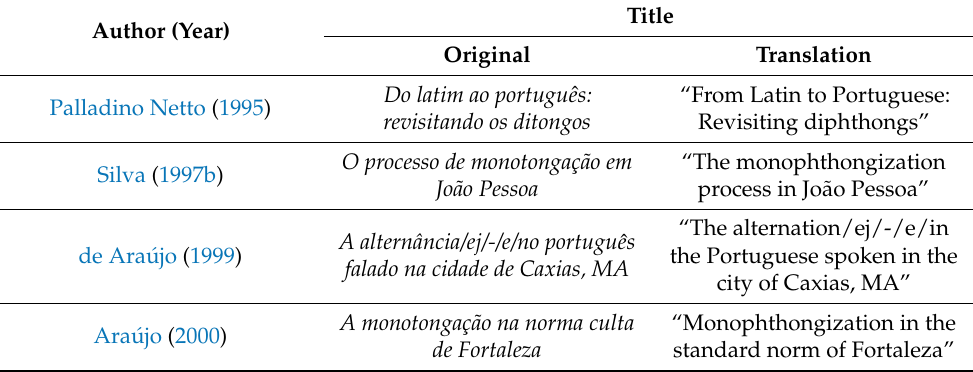
Table 1. Selected